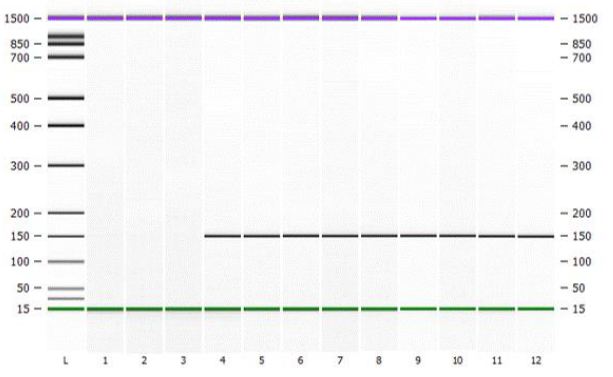
Figure 7. Capillary electrophoresis graph for DNA-traceable barcode labeling of Citrus sinensis. Purple lines are upper marker, green lines are lower marker. L is Ladder; lane 1 – 3 is the samples not labeled with DNA-traceable barcode; lane 4 – 12 is the samples labeled with DNA-traceable bar- code.